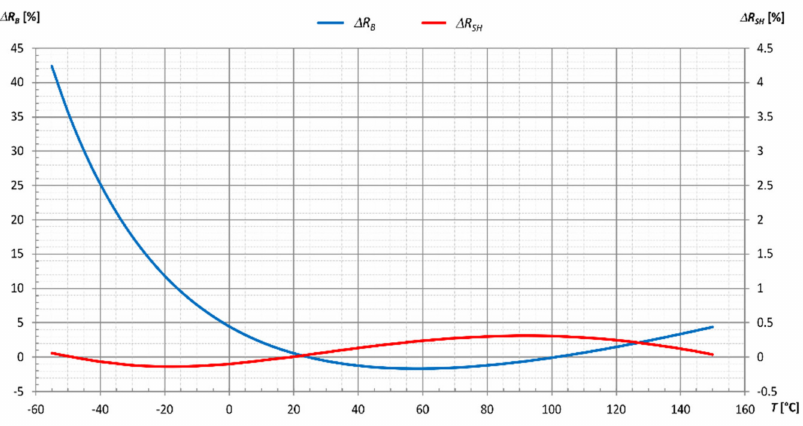
Figure 2. Resistance error for B equation and Steinhart–Hart